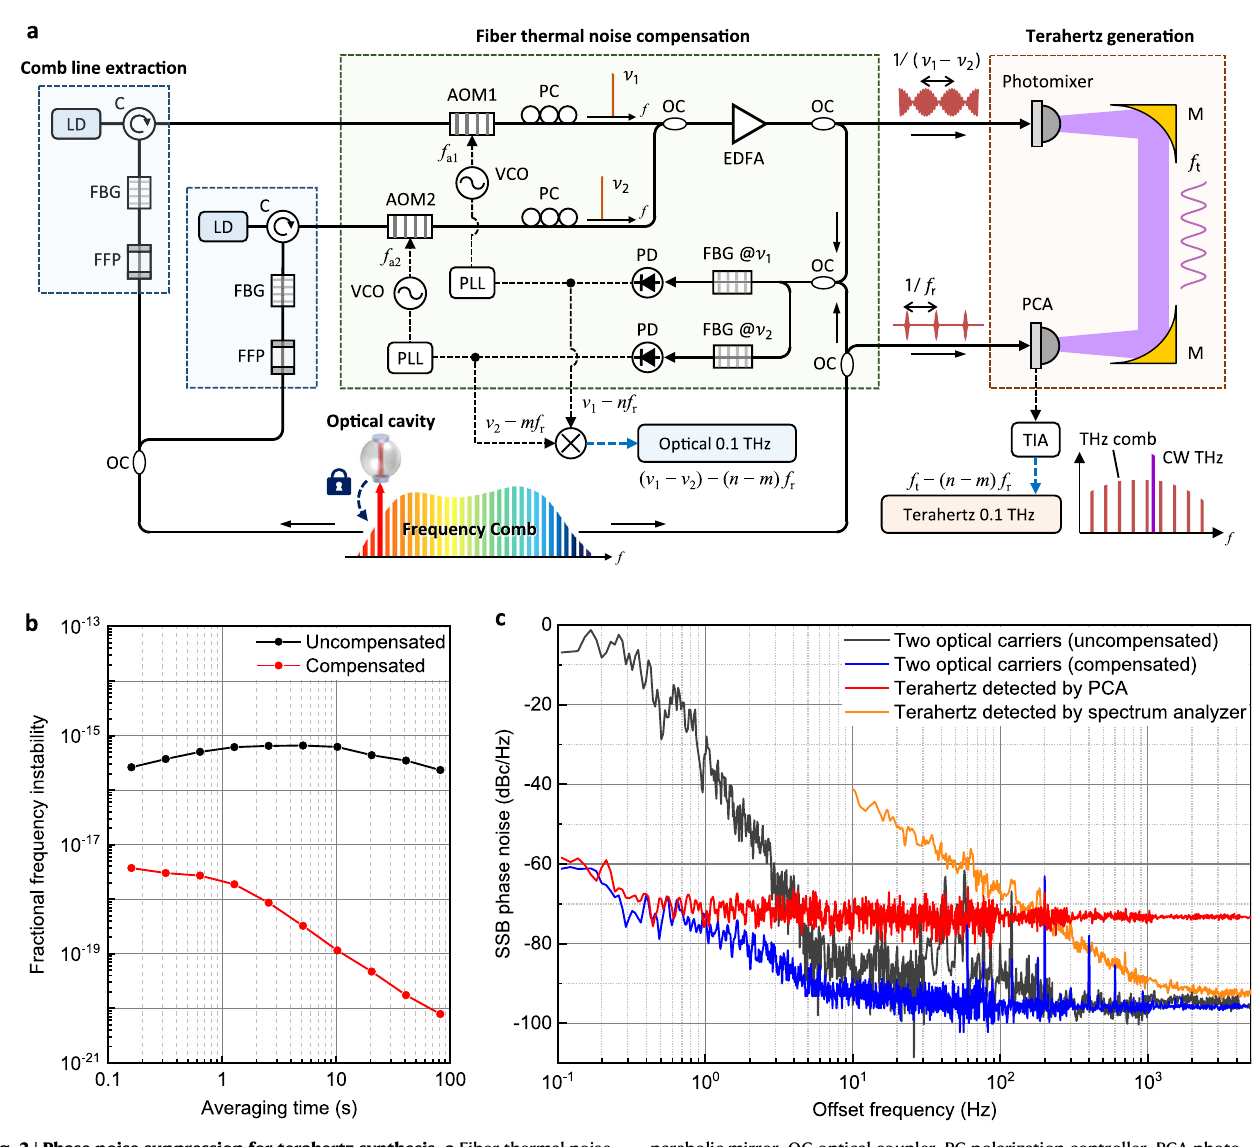
parabolic mirror, OC optical coupler, PC polarization controller, PCA photo- conductive antenna, PD photodetector, PDH Pound-Drever-Hall technique, PLL phase-locked loop, TIA transimpedance ampli fi er, VCO voltage-controlled oscilla- tor, WDM wavelength division